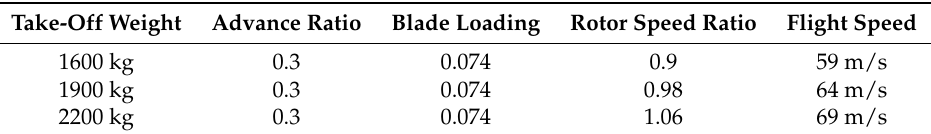
Table 3. Variable-speed rotor in fast flight speed cases.